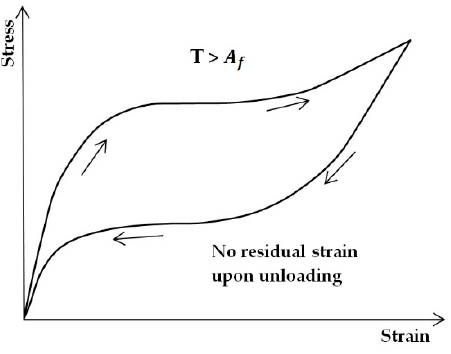
Figure 1. Super-elastic behavior of SMA.